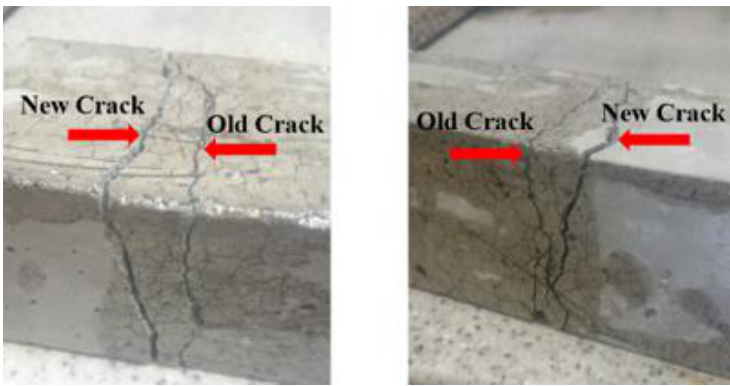
Figure 10. New and old cracks in the repaired reference specimens.